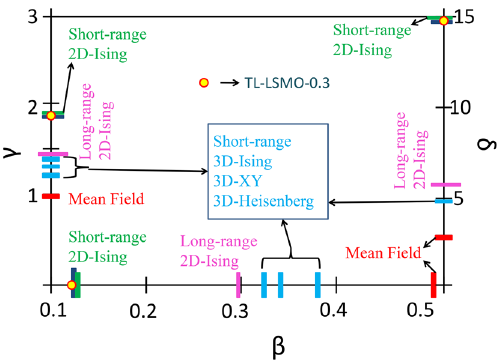
Figure 9. Comparison of different exponents of TL-LSMO-0.3 (denoted as closed circles filled with yellow color) with that of standard universality classes. Different vertical bars represents different models for short- range and long-range exchange interactions. Short-range → the 2D-Ising (green bar), 3D-Ising (sky blue bar), 3D-XY (sky blue bar) and 3D-Heisenberg (sky blue bar) and long-range → 2D-Ising model (pink bar). (The figure has been drawn using microsoft office powerpoint